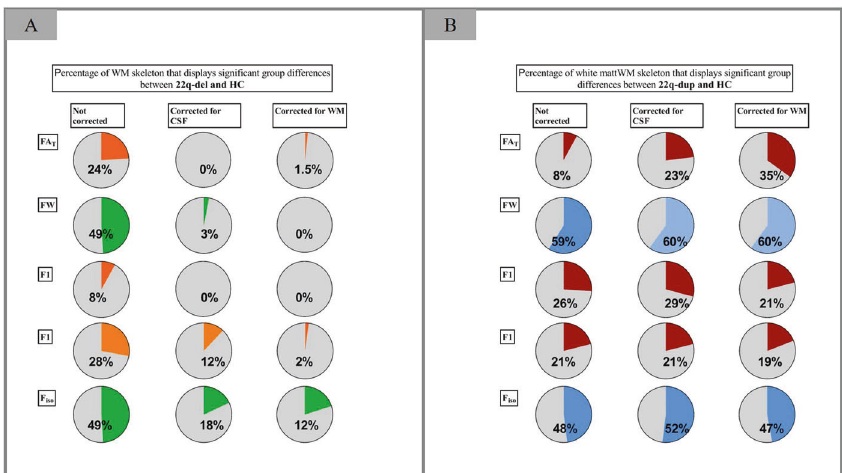
Fig. 3 The effect of controlling for macrostructural volume on the percentage of white matter (WM) skeleton that displays signi fi cant group differences. Comparing 22q11.2 deletion carriers (22q-del) and healthy controls (HC) (Panel A ) shows that without controlling for macrostructural volume (left column), 22q-del displays signi fi cant differences in all microstructural parameters (FAt, FW, F1, F2, F iso ). When controlling for relative cerebrospinal fl uid (CSF) volume (middle column) or relative WM volume (right column), these group differences disappear or diminish. Comparing 22q11.2 duplication carriers (22q-dup) and HC (Panel B ) shows that the percentage of skeleton voxels with signi fi cant fi ndings (left column) remain similar when controlling for CSF volume (middle row) or WM volume (right row).